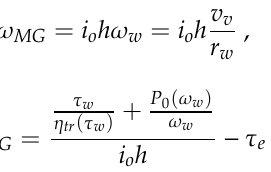
Figure 9. Functional scheme of considered parallel HEV/PHEV powertrain ( a ) and battery equivalent circuit model ( b ).